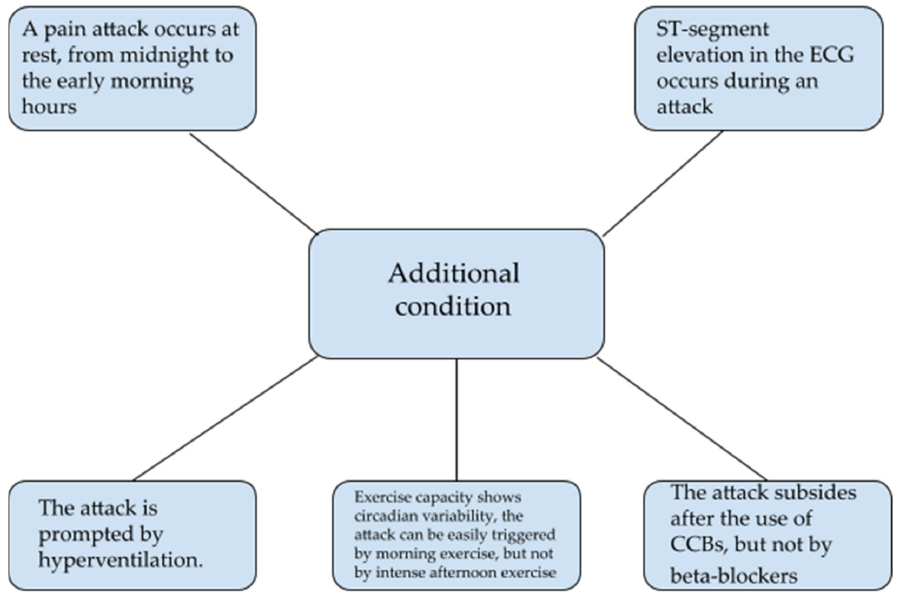
Table 3. Contraindications to the provocation test [1].